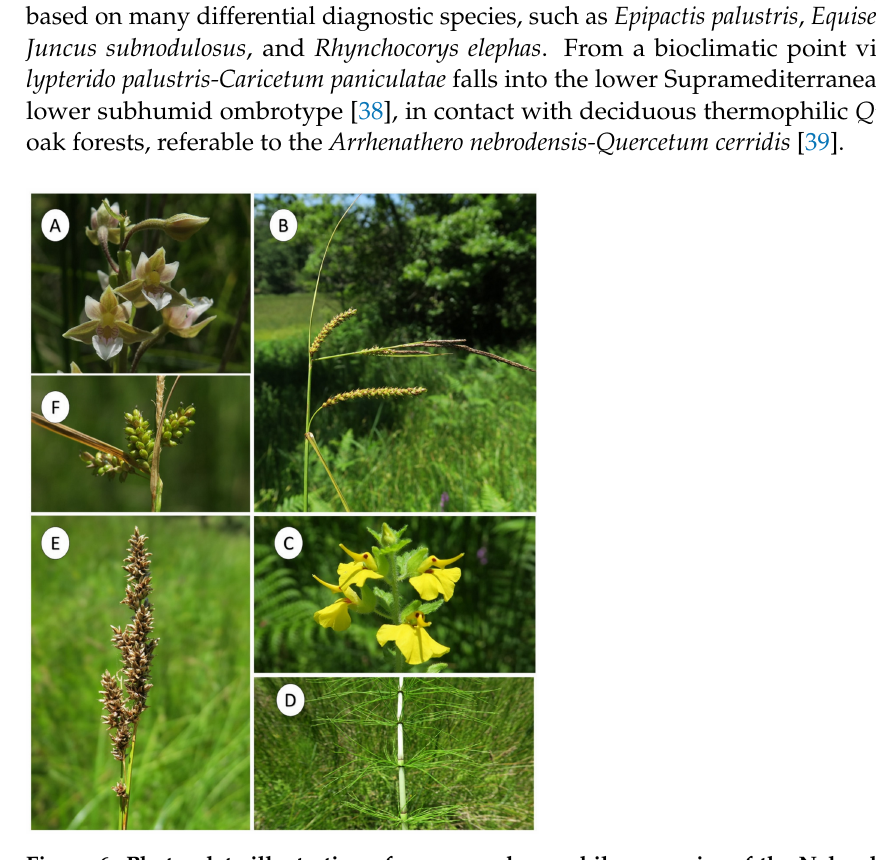
Figure 6. Photo plate illustration of some rare hygrophilous species of the Nebrodi Mountains: ( A ) Epipactis palustris ; ( B ) Carex flacca subsp. flacca ; ( C ) Rhynchocorys elephas ; ( D ) Equisetum palustre ; ( E ) Carex paniculata ; ( F ) Carex pallescens . (Photos of the